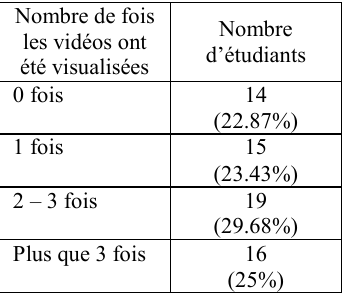
Tableau 1. Résultats de la partie 1 du